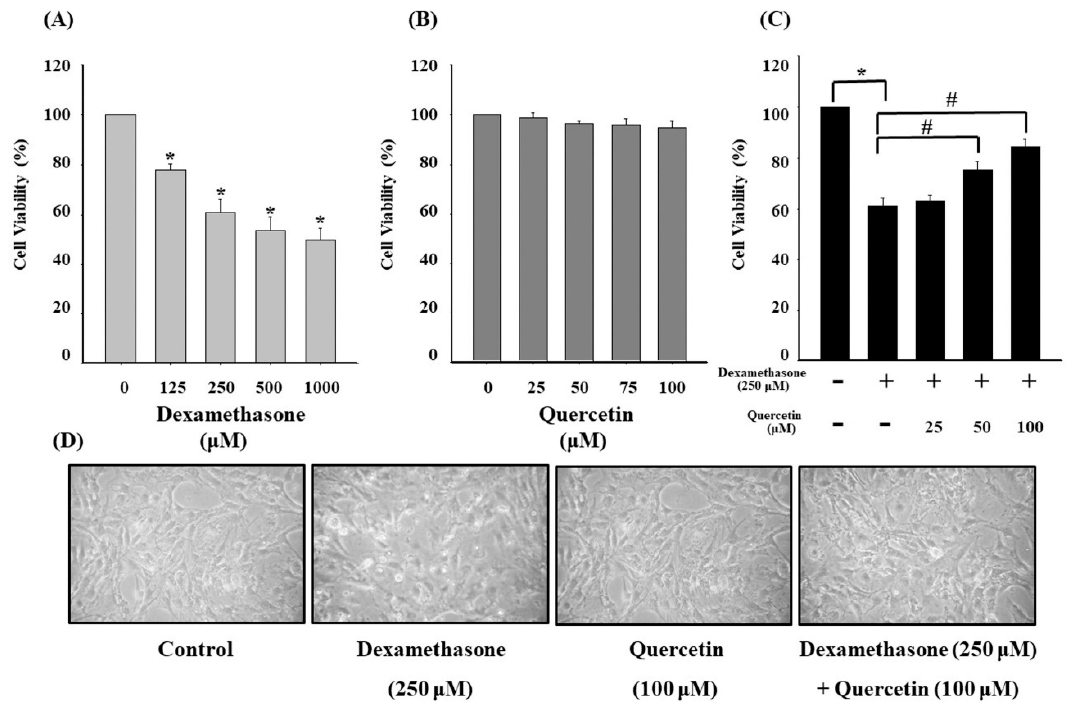
Figure 1. ( A ) Cell viability of C2C12 myotube cells in the presence of 0, 125, 250, 500, and 1000 μ M dexamethasone for 4 h. ( B ) Cell viability of C2C12 myotube cells in the presence of 0, 25, 50, 75, and 100 µ M quercetin for 24 h. ( C ) Cell viability of C2C12 myotube cells treated with 25, 50, and 100 μ M quercetin for 24 h and cotreated with 250 µ M dexamethasone for 4 h. ( D ) Morphological alterations of C2C12 myotube cells in the presence of 100 µ M quercetin for 24 h and cotreated with 250 µ M dexamethasone for 4 h. Values represent the mean ± SE (n = 8). Significant differences were determined using Dunnett’s test (* p < 0.05, compared with the untreated group; # p < 0.05, compared with the dexamethasone-treated group).